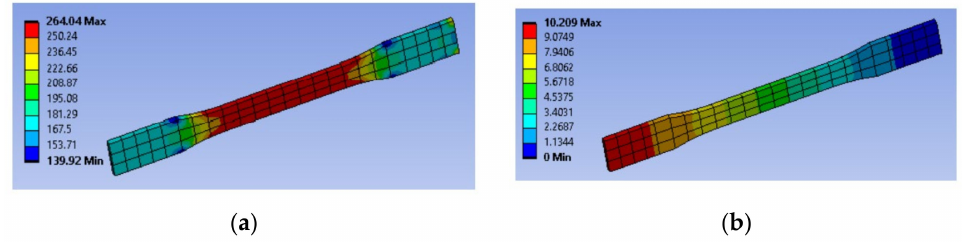
Figure 6. Sample outcomes of the simulation for ( a ) maximum stress (MPa) and ( b ) elongation